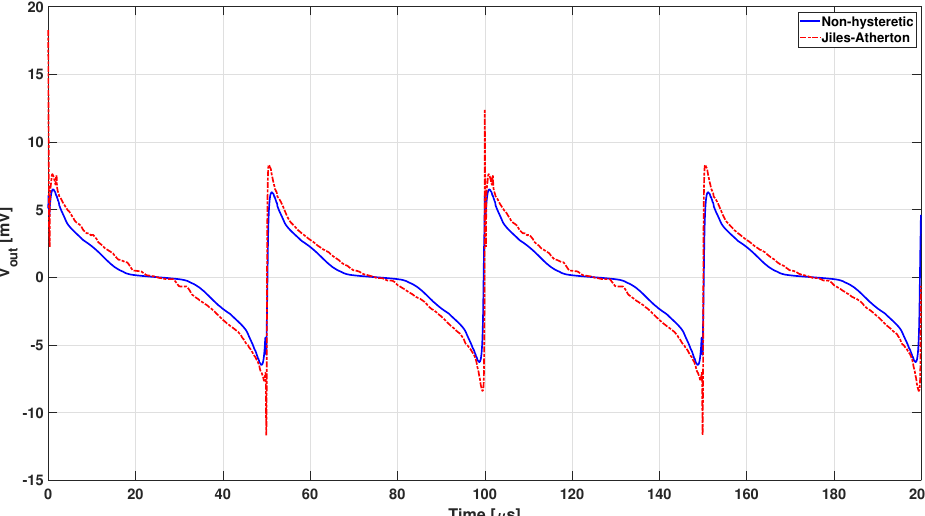
Figure 17. Output voltage obtained with the hysteretic Jiles–Atherton model with the JA1 parameters for an external magnetic field of 100 µ T (red dashed-dotted line), compared to the one calculated in the same condition with non-hysteretic B-H curve (solid blue